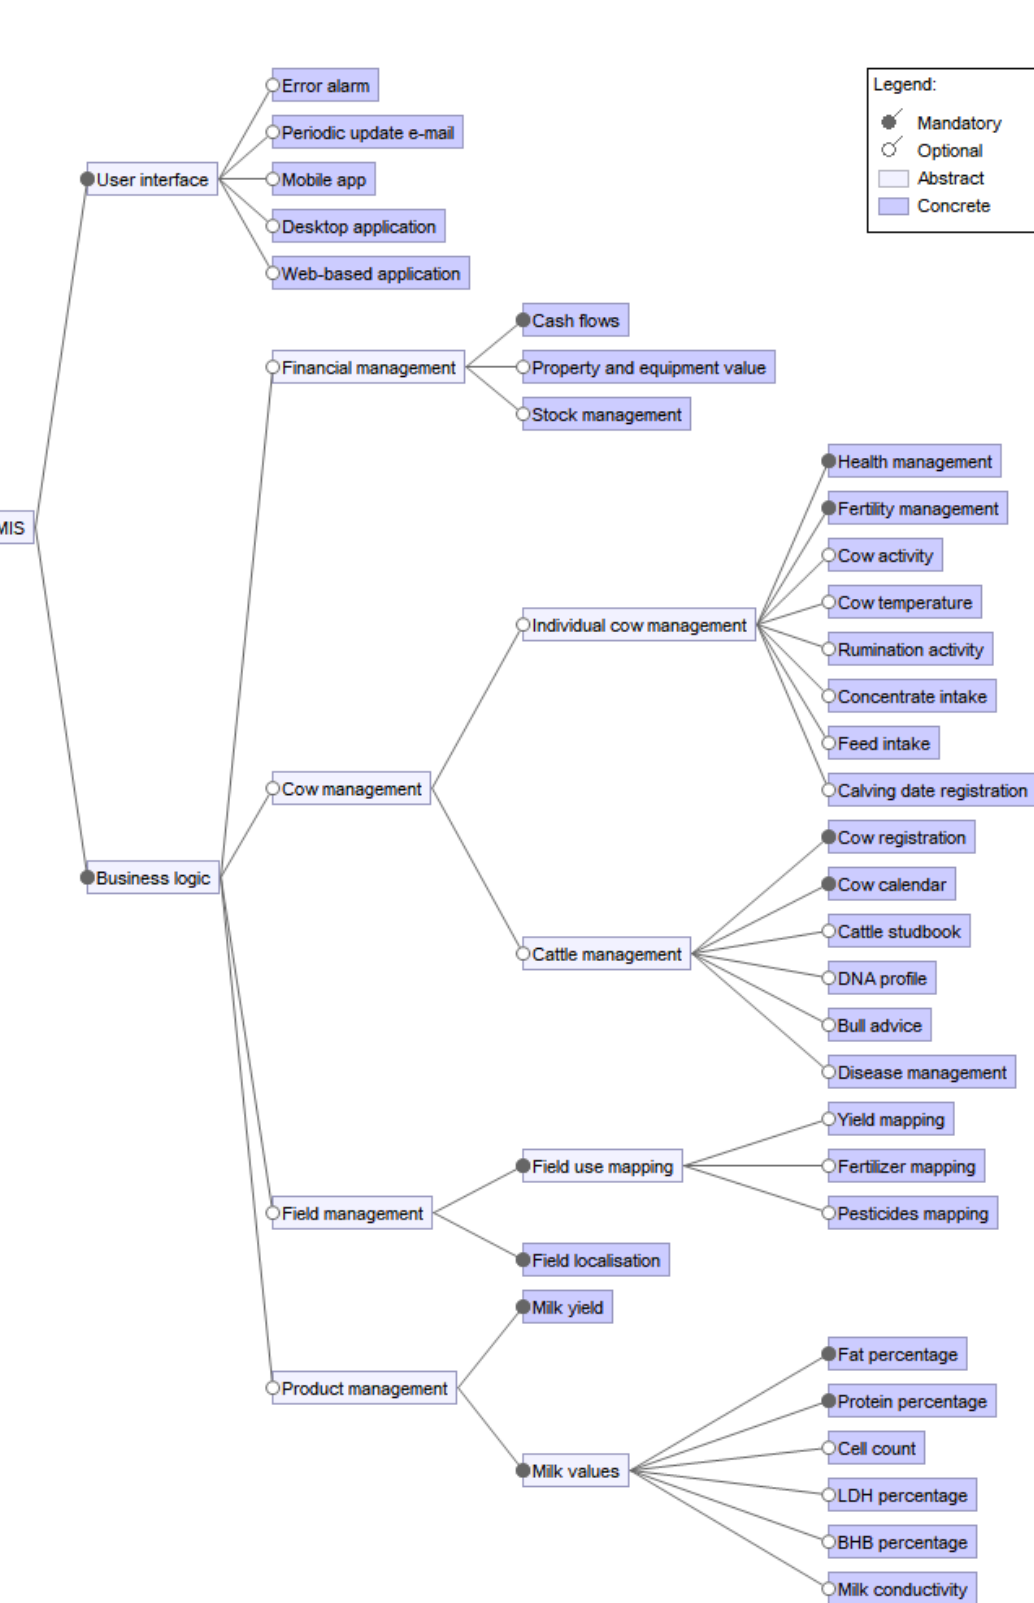
Figure 7. The feature model of FMISs in the Dutch dairy sector. As shown in this figure, FMIS systems collect and combine many types of data: fertility values, cow activity, rumination activity, concentrate feed intake, calving